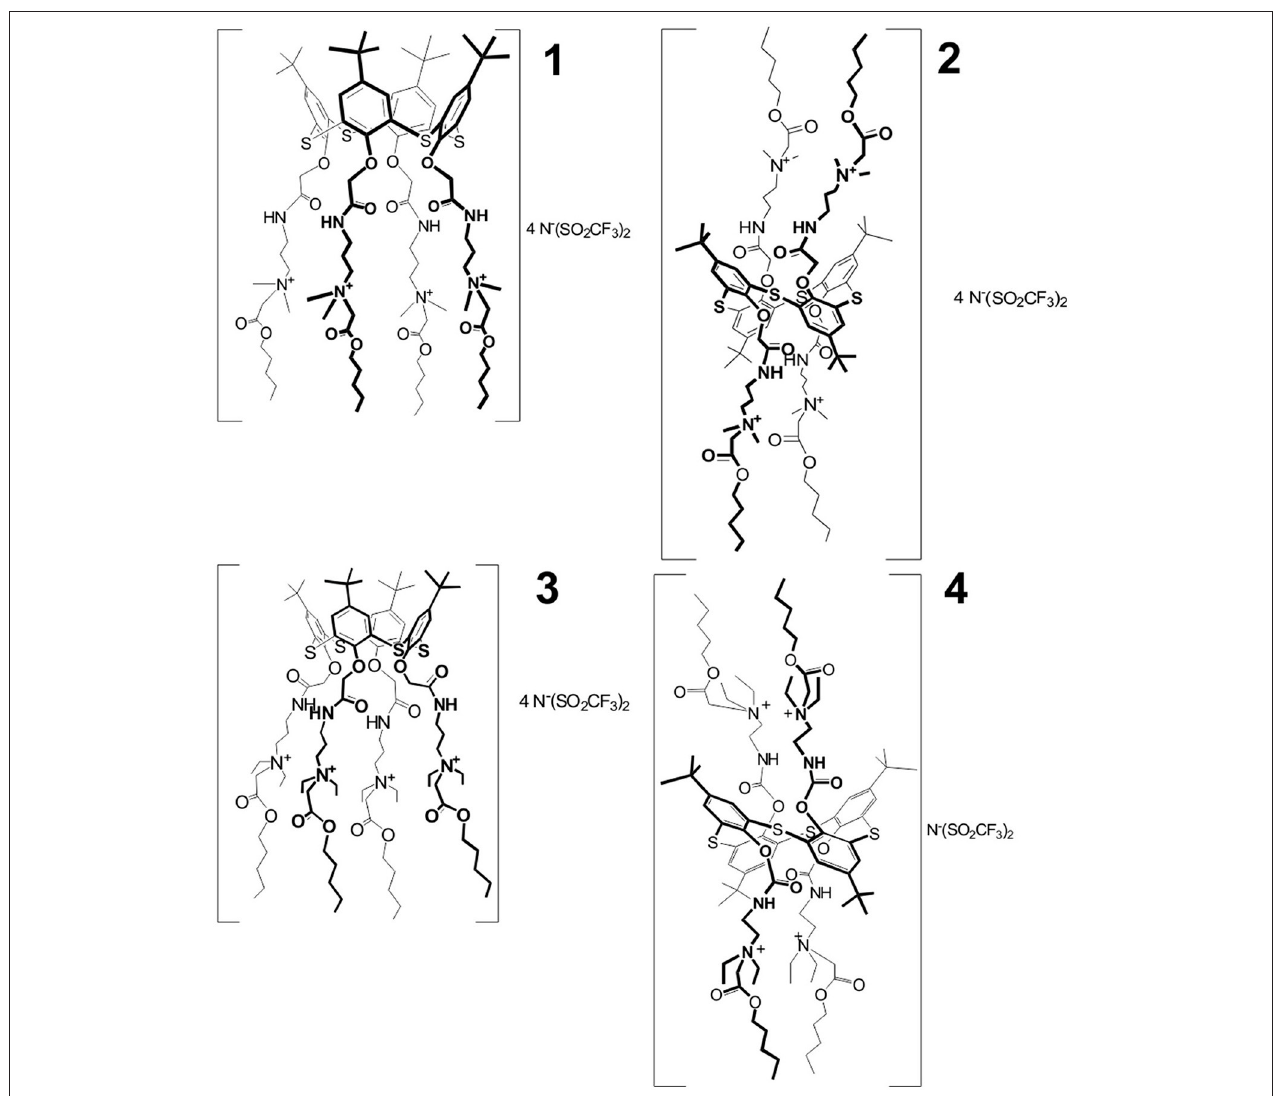
FIGURE 1 | Chemical structures of the ILs used in the assembly of potentiometric